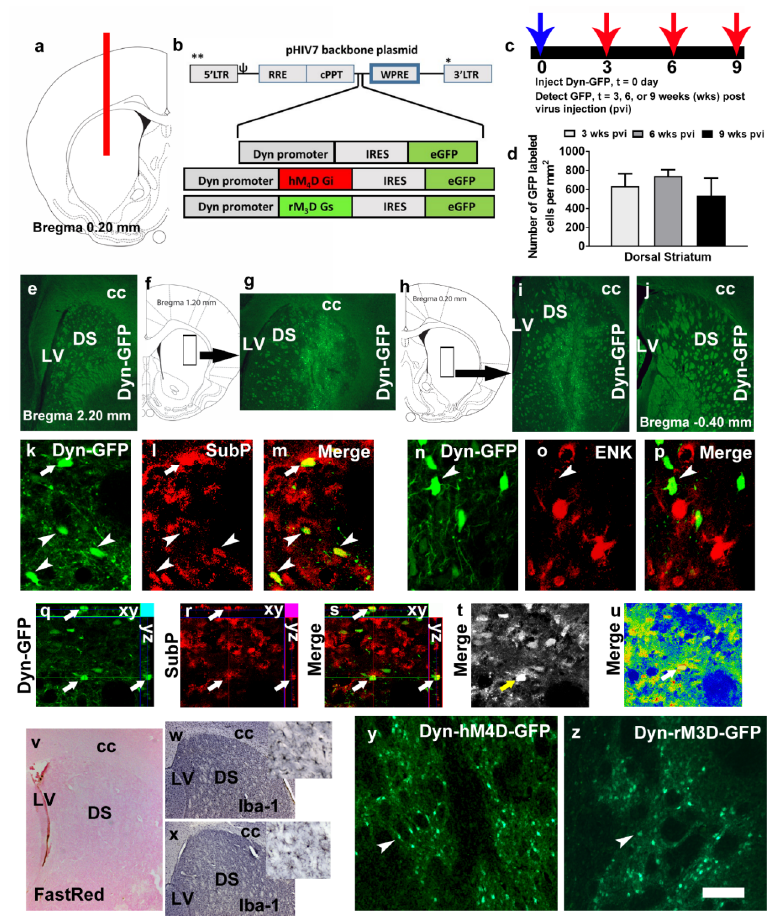
Figure 1. ( a ) Schematic representation of a coronal section through the dorsal striatum of the adult rat brain indicating the placement of injector needle for virus infusions. ( b ) Schematic of the lentiviral vector backbone indicating the genes of interest along with the dynorphin (Dyn) promoter that are inserted upstream of the WPRE in the pHIV-7 vector; IRES, internal ribosome entry site; eGFP, enhanced green fluorescent protein. ( c , d ) Time course of Dyn-GFP virus infection demonstrated that maximal expression was seen between 3–6 weeks after virus injection. ( d ) Quantitative analysis of Dyn-GFP positive cells in the striatum of virus injected animals; n = 2–4 each time point. Data is represented as mean ± SEM. ( e – j ) Coronal sections with Dyn-GFP positive neurons along the rostral-caudal direction of the dorsal striatum. The rectangular box in f, h indicates the striatal area labeled with Dyn-GFP neurons in g, i. LV, lateral ventricle; DS, dorsal striatum; cc, corpus callosum. ( k – m ) Colabeling of Dyn-GFP with SubP (CY3, red) a maker for D1R-MSNs; arrow and arrowheads in k–m point to colabeled immunoreactive cells. ( n – p ) Colabeling of Dyn-GFP with ENK (CY3, red) a maker for D2R-MSNs; arrowhead in n–p point to Dyn-GFP cell that is not colabeled with ENK cells. ( q – s ) Confocal z-stack images in orthogonal view indicating colabeling of the cell in ( k – m ) pointed with an arrow. Xy- and yz axis is indicated in q-s to demonstrate equal penetration of GFP and SubP antibodies. ( t , u ) Confocal images indicating detector gain ( t ; black and white image shows no red—overmodulation or green—undermodulation of cells and therefore the lasers have been optimized in the multi-channel image acquisition) and amplifier gain ( u ; rainbow image shows no red—overmodulation or blue—undermodulation of areas expressing cells; note that the area of the axon bundles are blue due to lack of any cellular bodies) of the section used for orthogonal view. GFP, green fluorescent protein; SubP, substance P; ENK, enkephalin. ( v ) Virus injected section stained with Vector FastRed showing minimal damage to the dorsal striatum. ( w , x ) Iba-1 staining via DAB in virus naïve ( w ) and Dyn-GFP ( x ) injected rat. ( y , z ) GFP immunoreactivity in the dorsal striatum of a rat injected with Dyn-hM4D-GFP ( y ) and Dyn-rM3D-GFP ( z ). Scale bar in u is 200 um applies to e, g, i, j, v, w, x; 20 um applies k–p; 30 um applies q–u; 70 um applies